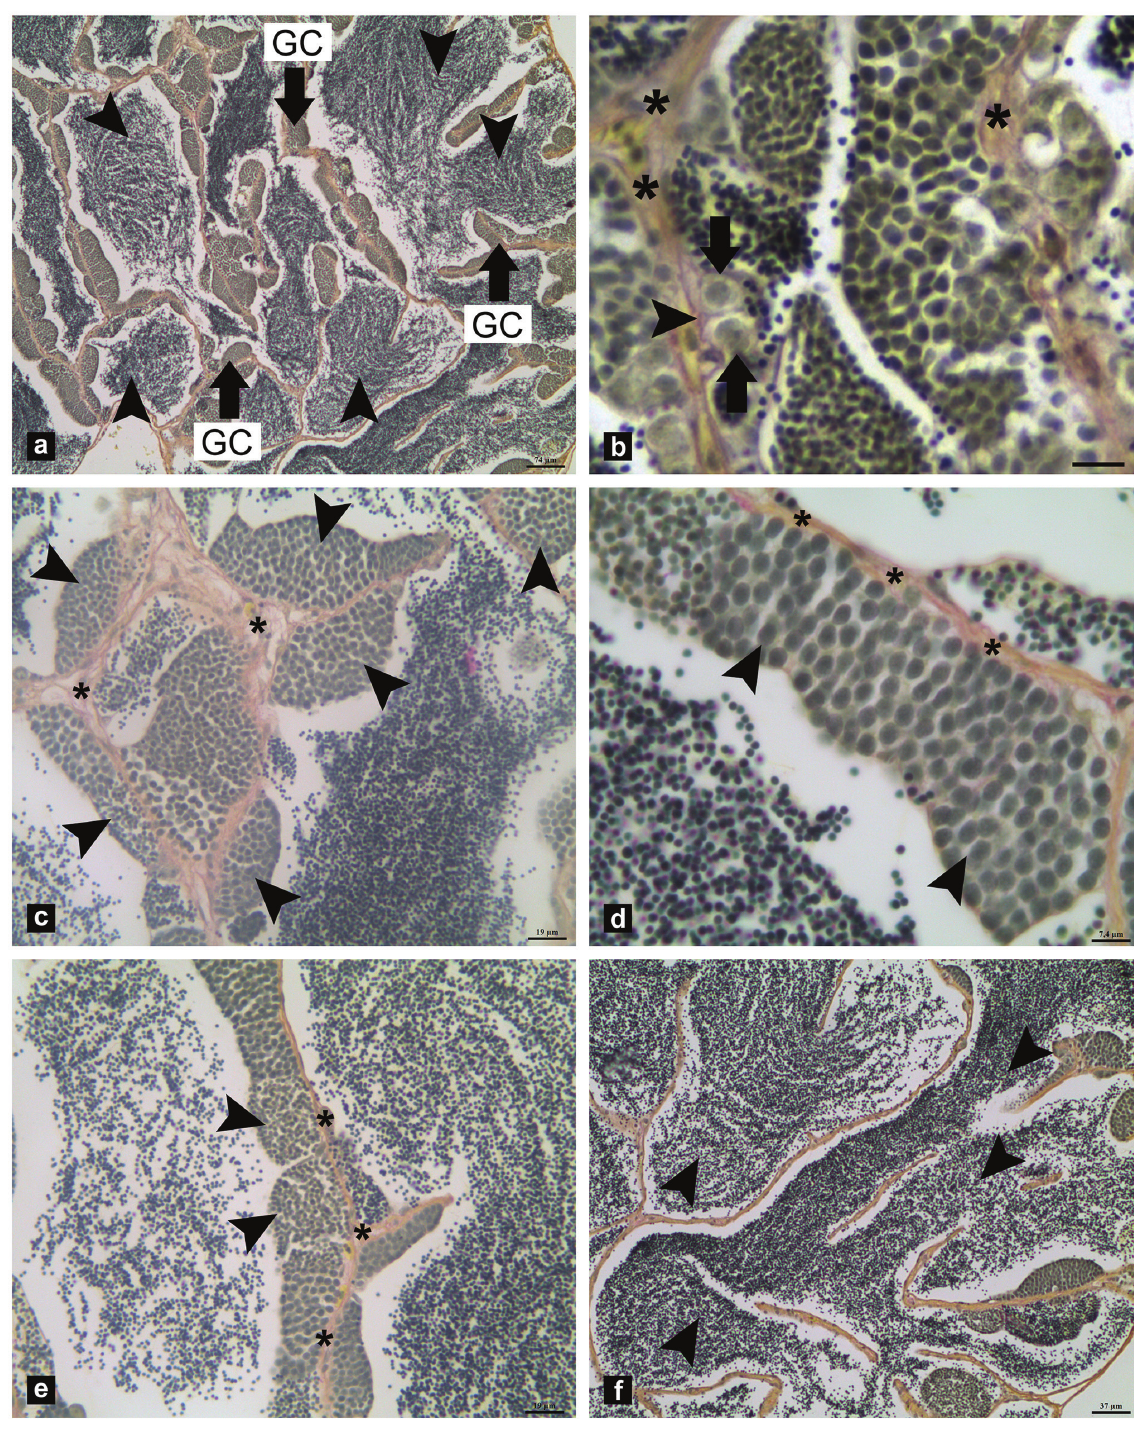
Fig. 2. Micrographs of the testes of Steindachneridion parahybae juveniles in captivity showing the different germ cell types. a) unrestricted spermatogonial testes with anastomosing tubular type, composed by numerous tubules (arrowhead), which contained the germinal compartment (GC, indicate with arrow) and separated by interstitial tissue; b) isolated spermatogonia cell (arrow) surrounded by Sertoli cells (arrowhead), separated by interstitial tissue (asterisk); c) many spermatocytes and spermatids within the cysts (arrowhead), separated by interstitial tissue (asterisk); d) cysts of spermatocytes (arrowhead), separated by interstitial tissue (asterisk); e) cysts of spermatids (arrowhead), separated by interstitial tissue (asterisk); f) many spermatozoa inside the tubular lumen (arrowhead). Periodic-Acid-Schiff (PAS)/Weigert’s Haematoxylin/Metanil Yellow staining. Scale bars: 74µm (a); 37 µm (f); 19 µm (c,e); 14 µm (b); 7.4 µm